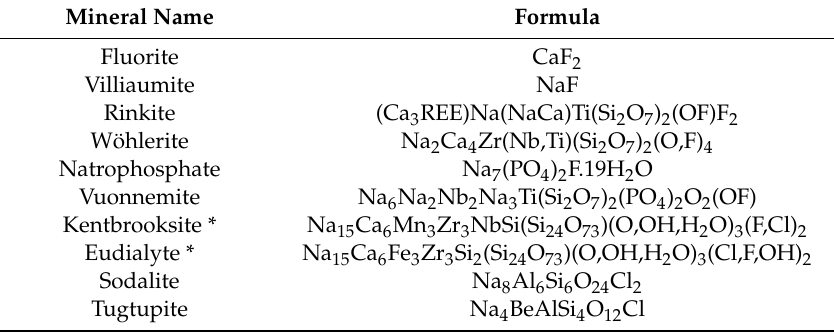
Table 1. Most common F − and Cl − bearing minerals in peralkaline systems. Eudialyte and kentbrooksite (*) are sometimes considered two endmembers of the eudialyte group, where eudialyte (*) is the Si, Fe, Cl and kentbrooksite the Nb,Mn,F